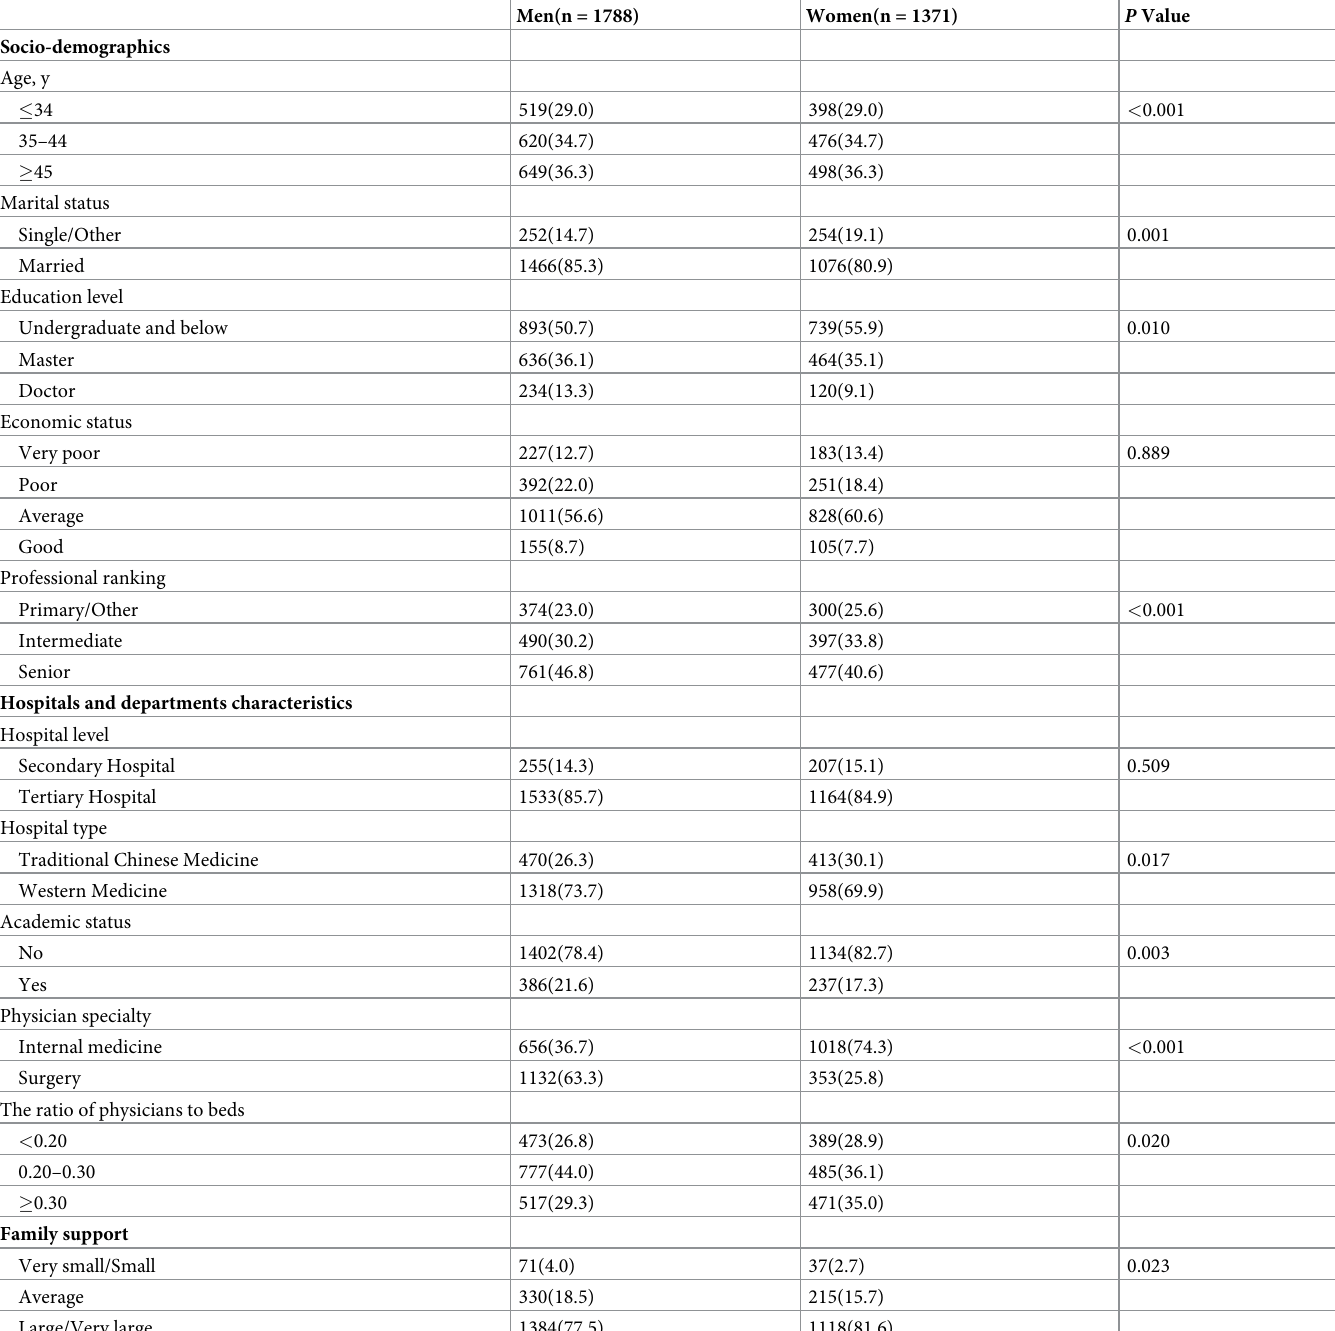
Table 1. The primary characteristics of participants, hospitals and